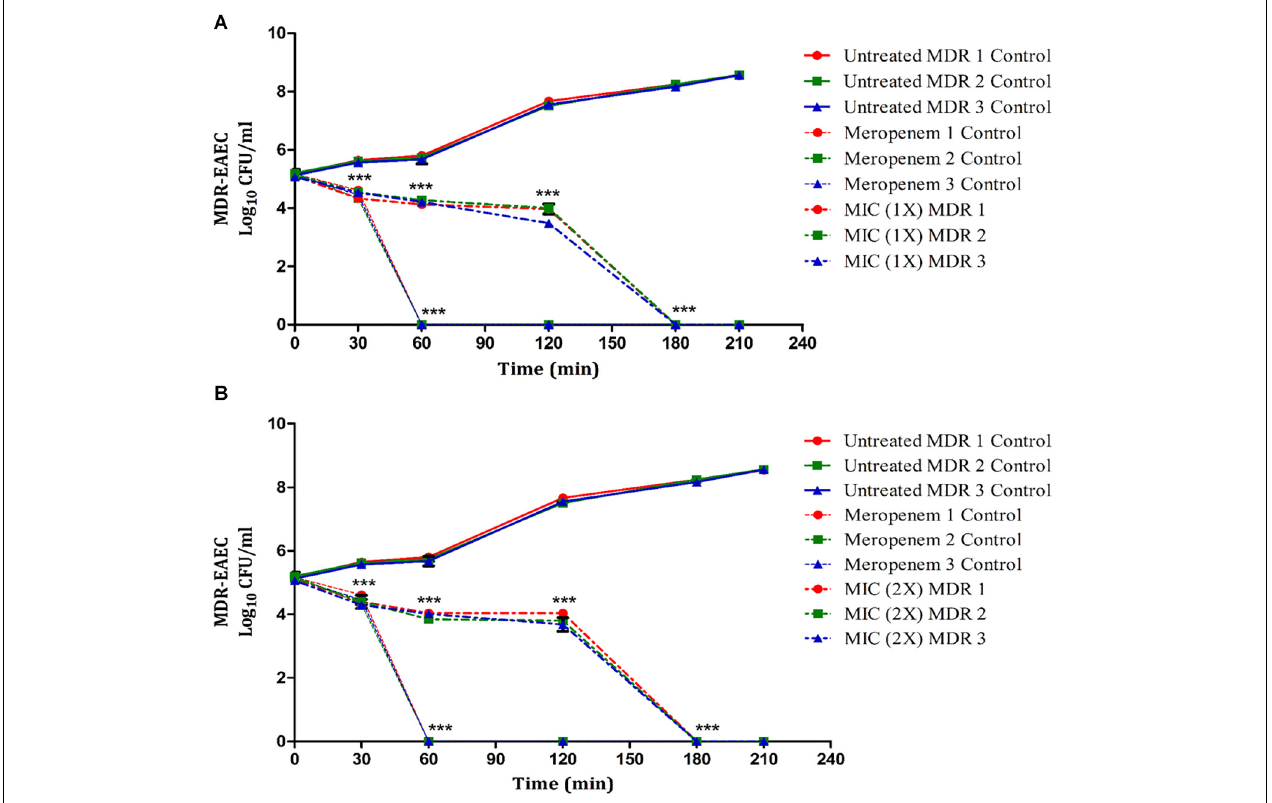
FIGURE 2 | Dose- and time-dependent time-kill assay of MDR-EAEC isolates co-cultured with Lfcin (17–30). MDR-EAEC isolates ( n = 3) were co-cultured with 1 × MIC of Lfcin (17–30) (A) and 2 × MIC of Lfcin (17–30) (B) in CA-MH broth at 37 ◦ C under static conditions with respective controls of MDR-EAEC isolates (untreated and meropenem-treated). Data expressed as the mean ± standard deviation (log 10 CFU/ml) of three independent experiments (*** P < 0.001).